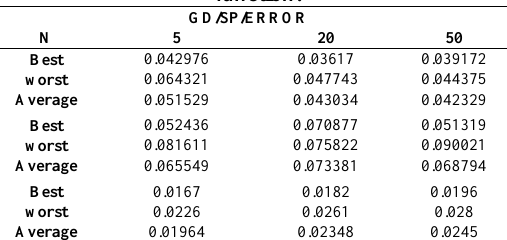
Table 7. GD/SP/ERROR analysis on third test function.